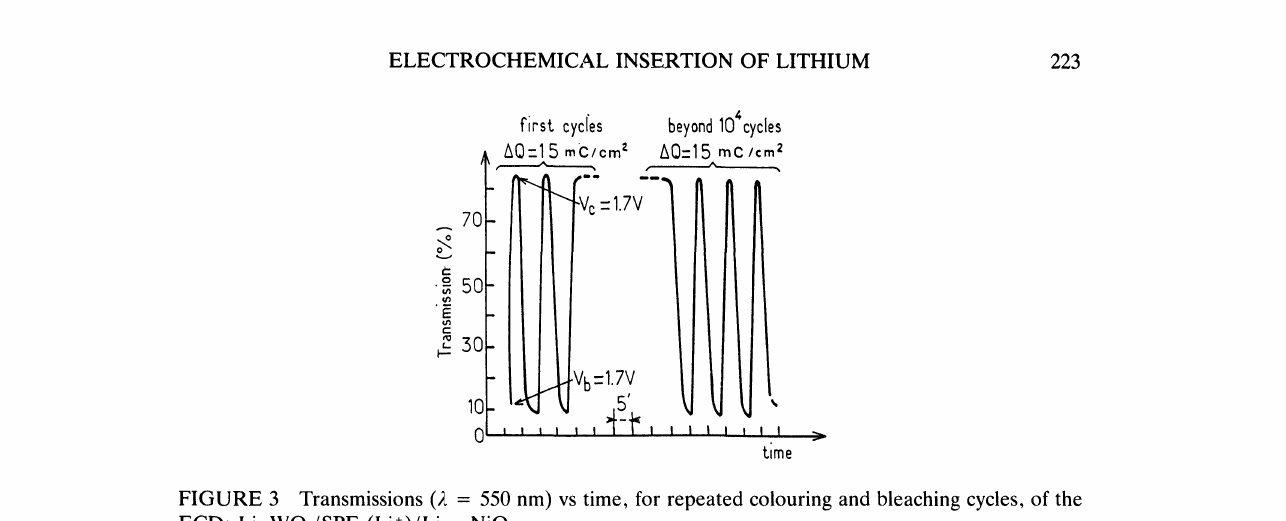
FIGURE 3 Transmissions (2 550 nm) vs time, for repeated colouring and bleaching cycles, of the ECD" Lix WO3/SPE (Li/)/Li2_x